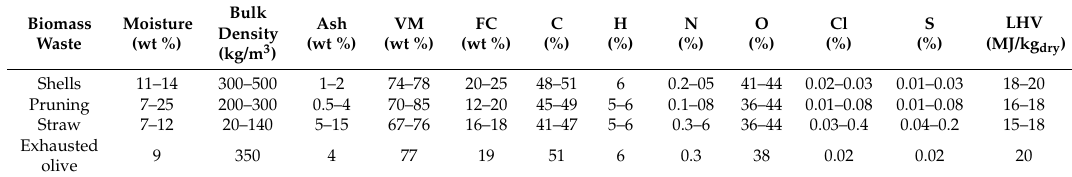
Table 1. Preliminary and definitive biomass waste properties [13].